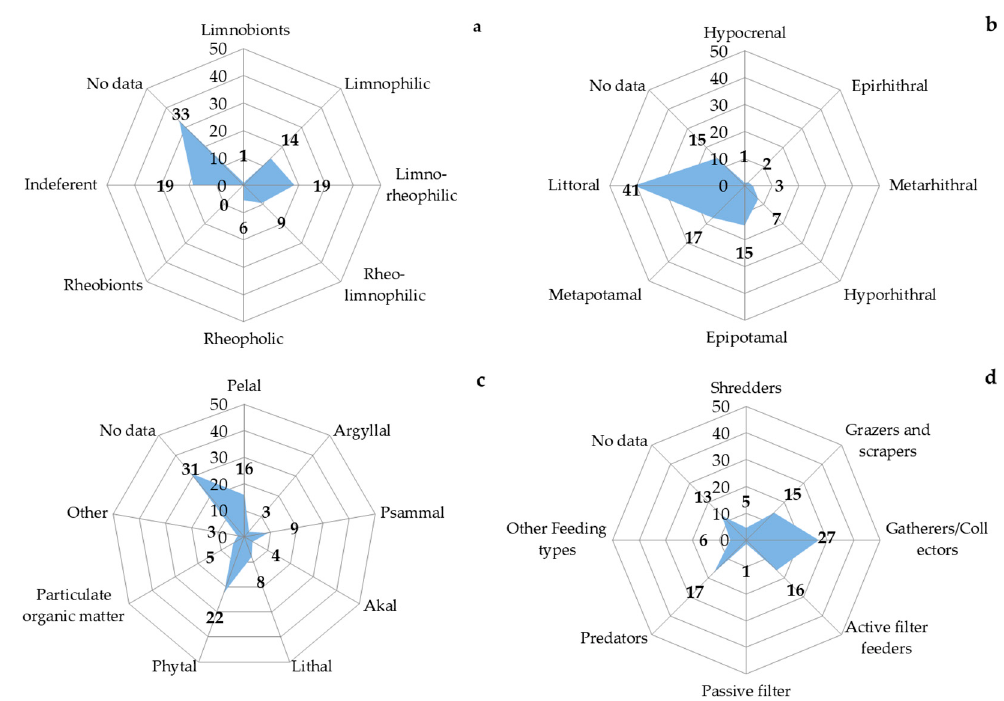
Figure 8. Autecological preference composition (%) of macrozoobenthos in the Lower Dniester in 2018–2020 calculated using total taxa list with Asterics 4.04. ( a ) Current preference, ( b ) zonation, ( c ) biotope, and ( d ) functional feeding group.